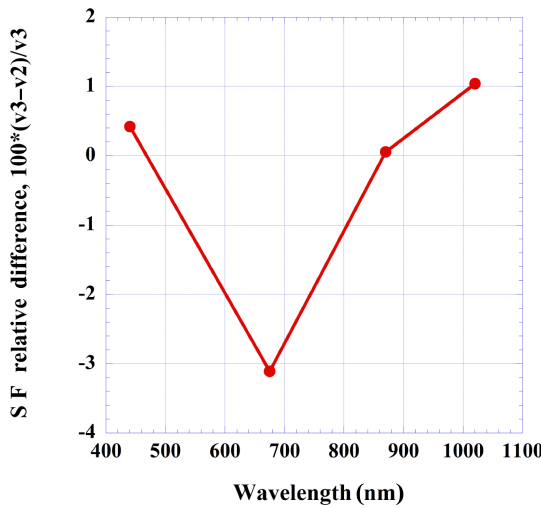
Figure 4. The relative percent difference in spectral solar flux data used in V2 (ASTM E-490 https://www.nrel.gov/grid/ solar-resource/spectra.html, last access: 8 June 2020) and V3 (Cod- dington et al., 2012) for four standard AERONET sky wavelengths (i.e., 440, 675, 870, and